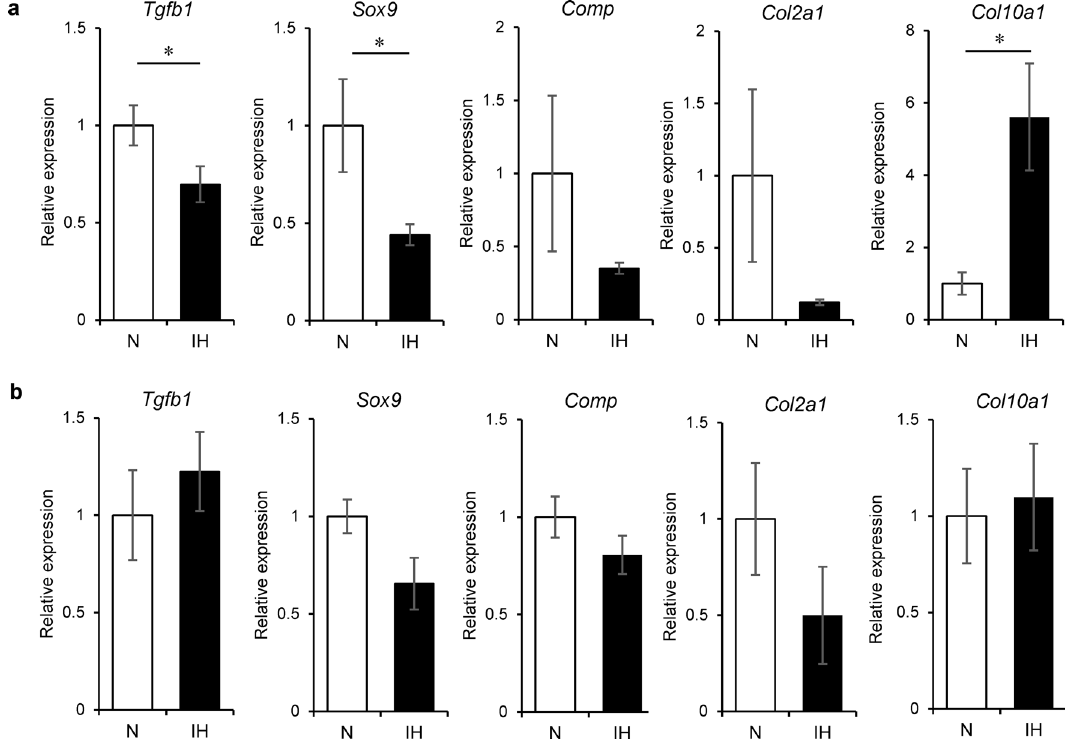
Figure 7. Differential effects of IH on expression levels of genes associated with chondrocyte and bone metabolism in mandibular condyle and tibia. Relative mRNA expression levels of bone metabolic regulator TGF-β ( Tgfb1 ) and chondrocyte markers SOX9 ( Sox9 ) , COMP ( Comp ), Collagen II ( Col2a1 ), Collagen X ( Col10a1 ), and RUNX2 ( Runx2 ) in mandibular condylar cartilage ( a ) and tibial cartilage ( b ). Data are mean ± SEM for each group. * P <